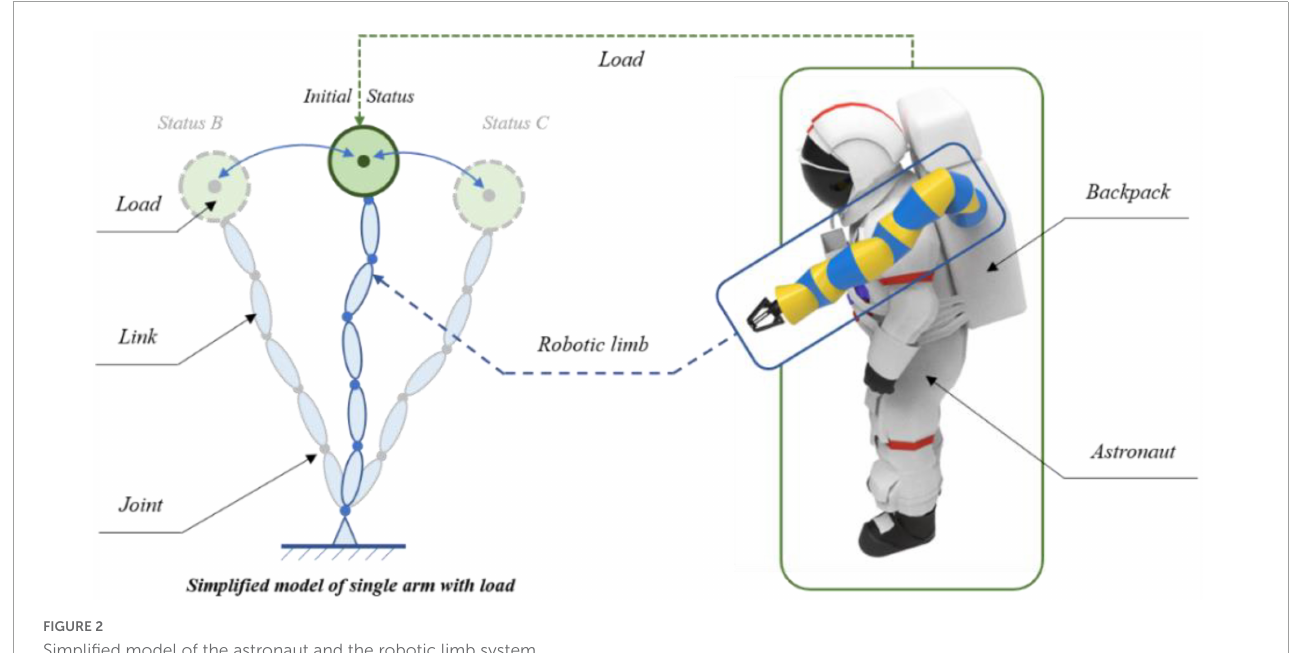
FIGURE2 Simplified model of the astronaut and the robotic limb system.